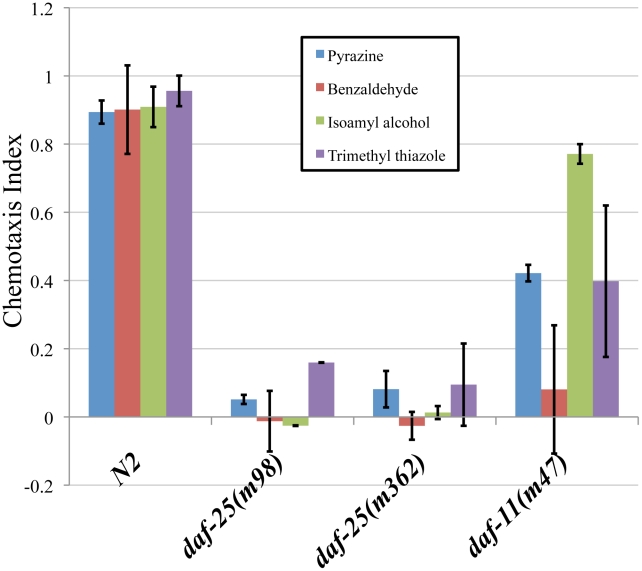

daf-25 mutants have chemosensory defects.We assayed the ability of two daf-25 mutants to respond to four attractants. The daf-25 behavior was compared with N2 and with daf-11(m47), which is partially chemotaxis defective. Chemotaxis index scores were calculated as the number of adults at the attractant minus the number at the control, divided by the total number of adults [50]. Neither allele of daf-25 responded to any of the attractants, indicating an olfactory defect in daf-25 mutants that is more severe than that of the daf-11 guanylyl cyclase mutant. Benzaldehyde, trimethyl thiazole and isoamyl alcohol are detected by the AWC neurons, and pyrazine by the AWA neurons. Pyrazine: N2 n = 66, daf-25(m98) n = 78, daf-25(m362) n = 123, daf-11(m47) n = 83. Benzaldehyde: N2 n = 91, daf-25(m98) n = 80, daf-25(m362) n = 115, daf-11(m47) n = 62. Isoamyl alchohol: N2 n = 66, daf-25(m98) n = 78, daf-25(m362) n = 78, daf-11(m47) n = 83. Trimethyl thiazole: N2 n = 91, daf-25(m98) n = 69, daf-25(m362) n = 74, daf-11(m47) n = 93.